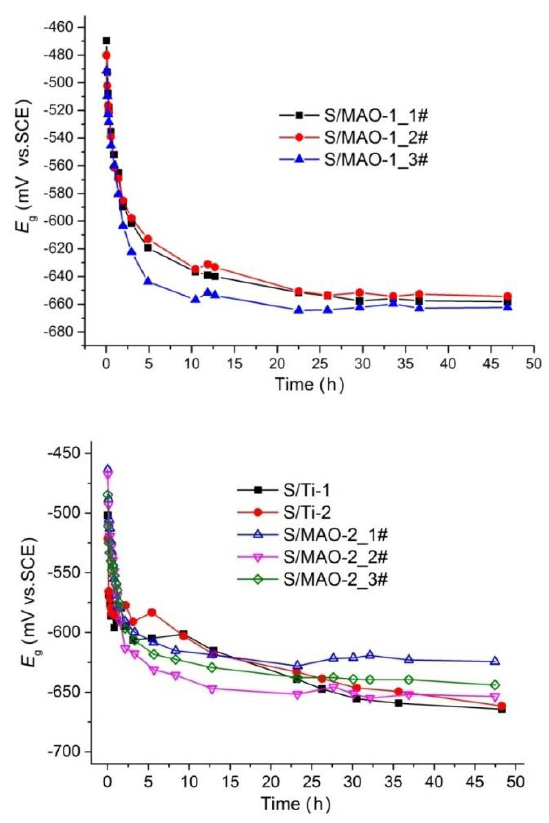
Figure 13. Change curves of galvanic potential of S/MAO-1, S/MAO-2, and S/TA2 couples with time in 3.5% NaCl solution.